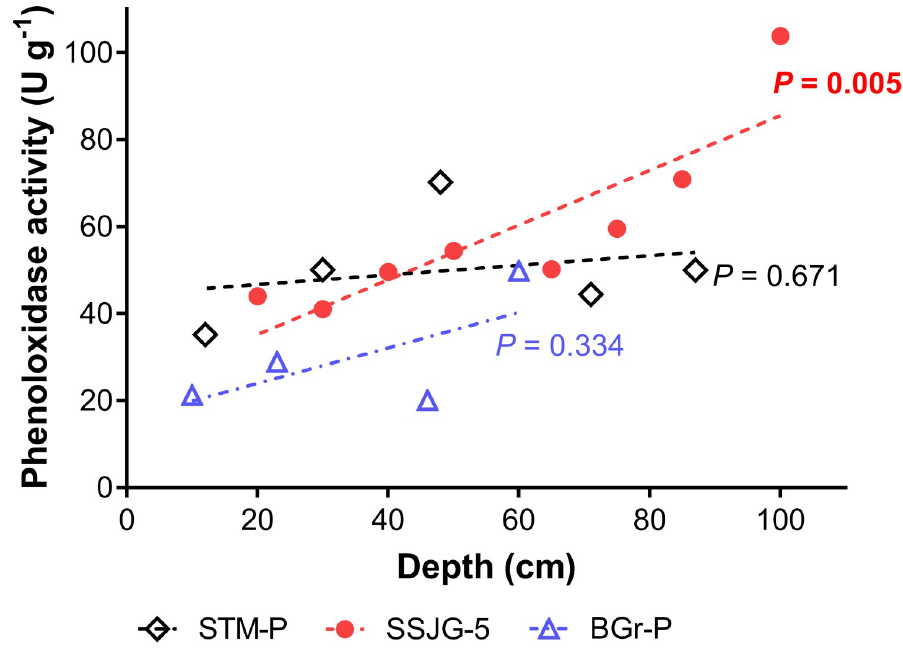
Fig 5. Extracellular phenoloxidase activity versus depth across sample sites. STM-P (R 2 = 0.068), SSJG-5 (R 2 = 0.75), and BGr-P (R 2 = 0.44).